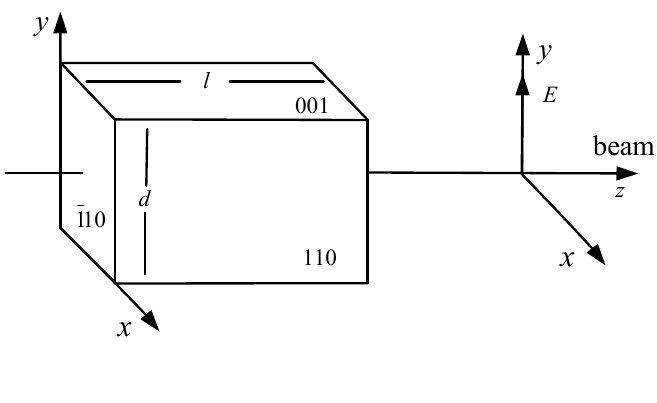
Figure 1. Orientation of the BGO crystal used in the OVS.